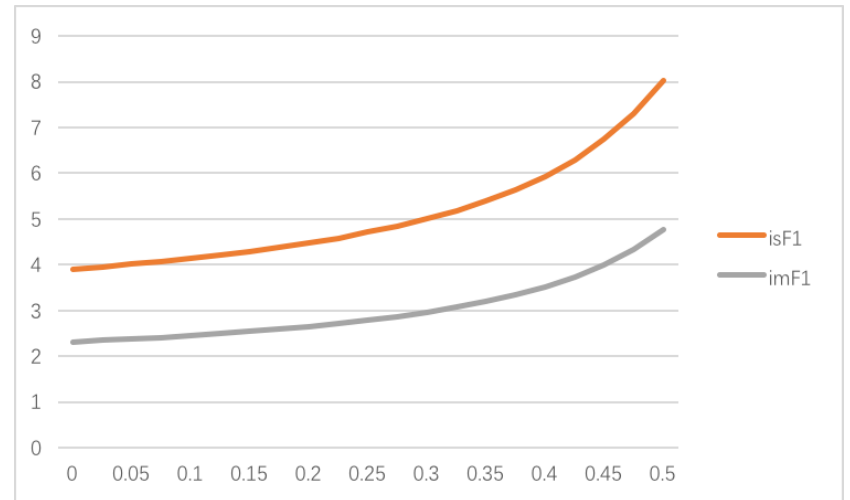
Figure 2. Impact of θ on the sustainable green technology innovation efforts when only the supplier concerns about